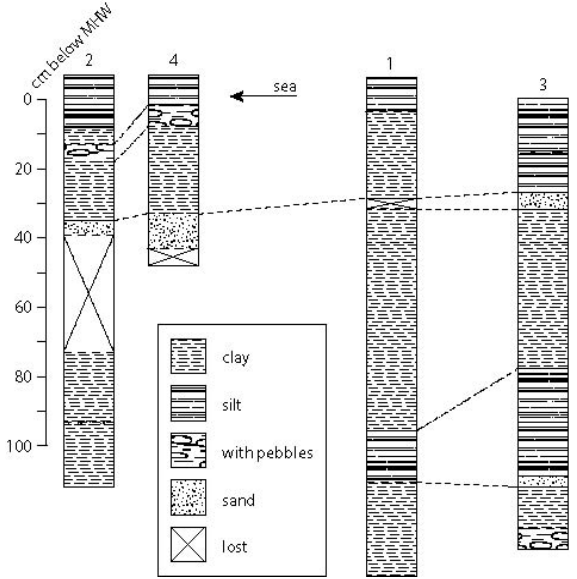
Fig. 7. Lithostratigraphy of Aliki. Cores 2 and 4 are located at the seaward side of the lagoon just behind the barrier and cores 1 and 3 at the landward